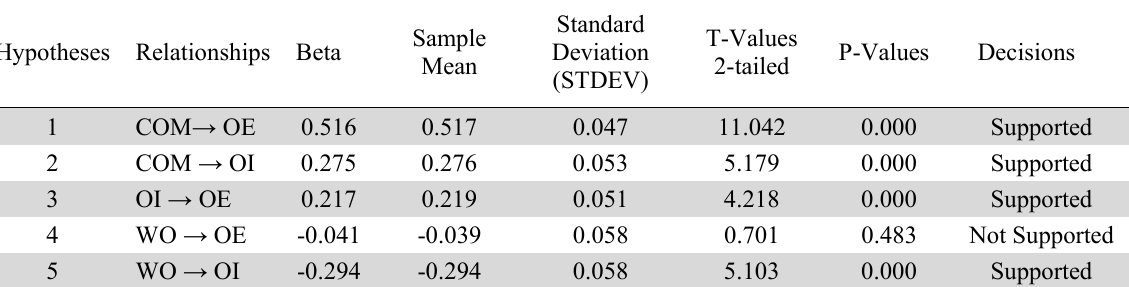
Results of the Structural Model Path